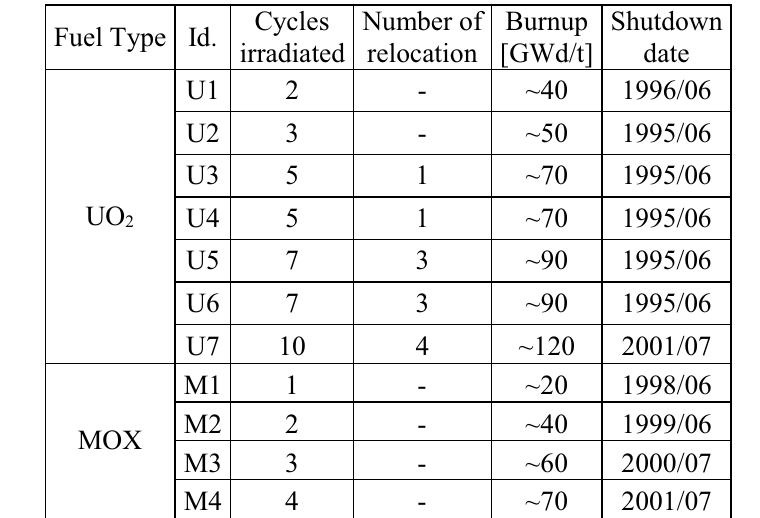
Table I.: Measured LWR-PROTEUS segments characteristics